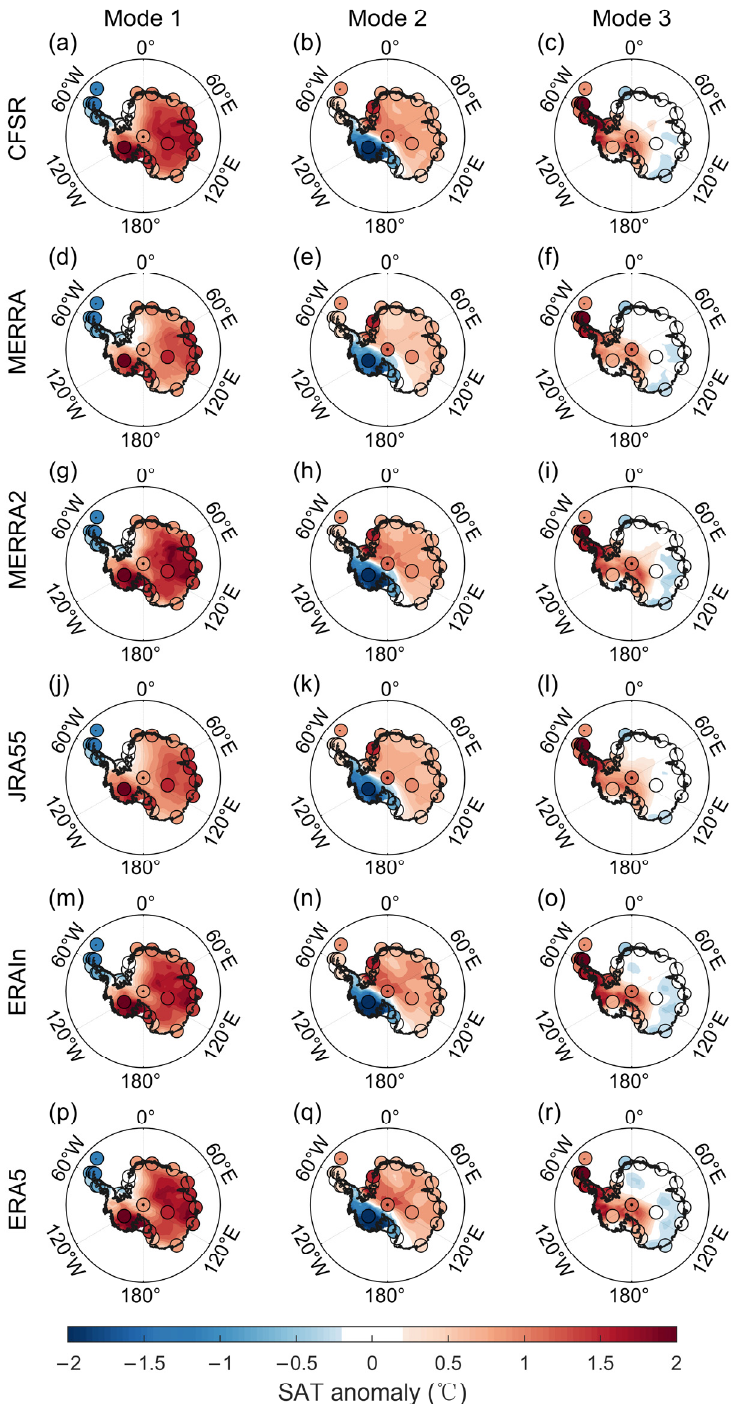
Figure 4. The spatial patterns of the first three modes of the combined maximum covariance analysis (CMCA) for each reanalysis dataset. The color shadings in ( a , d , g , j , m , p ) show the spatial patterns of CMCA Mode1 for the CFSR ( a ), MERRA ( d ), MERR2 ( g ), JRA55 ( j ), ERAIn ( m ), and ERA5 ( p ). The dots depict the spatial patterns of station observations. ( b , e , h , k , n , q ) and ( c , f , i , l , o , r ) are the same as ( a , d , g , j , m , p ), but for Mode2 and Mode3, respectively.